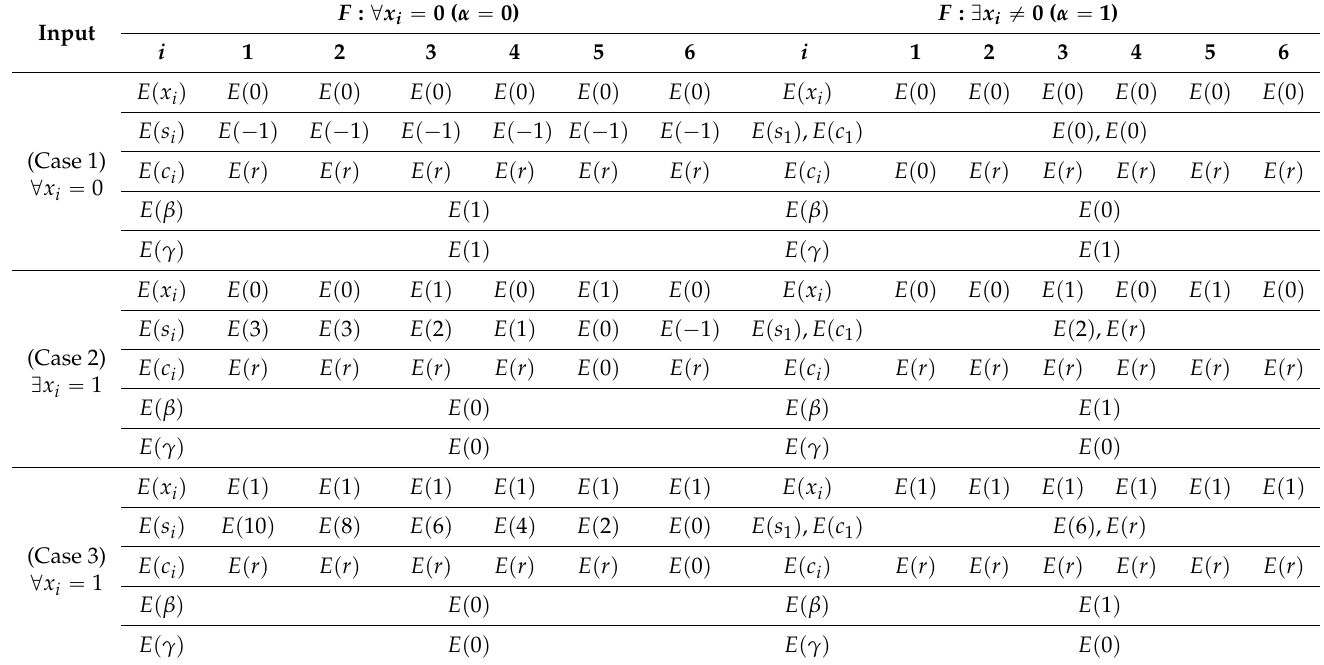
Table A1. Example of Algorithm A1 for SZP ( l “